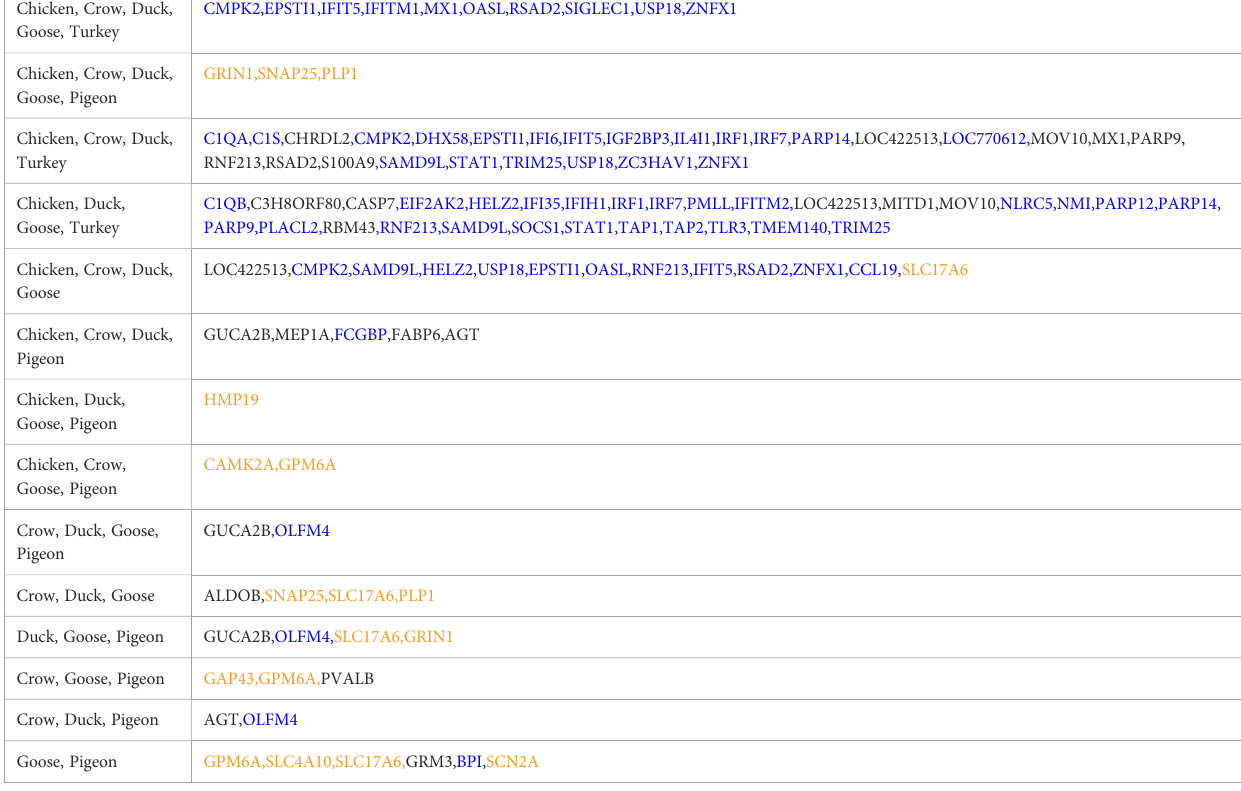
TABLE 3 Common DEGs in key